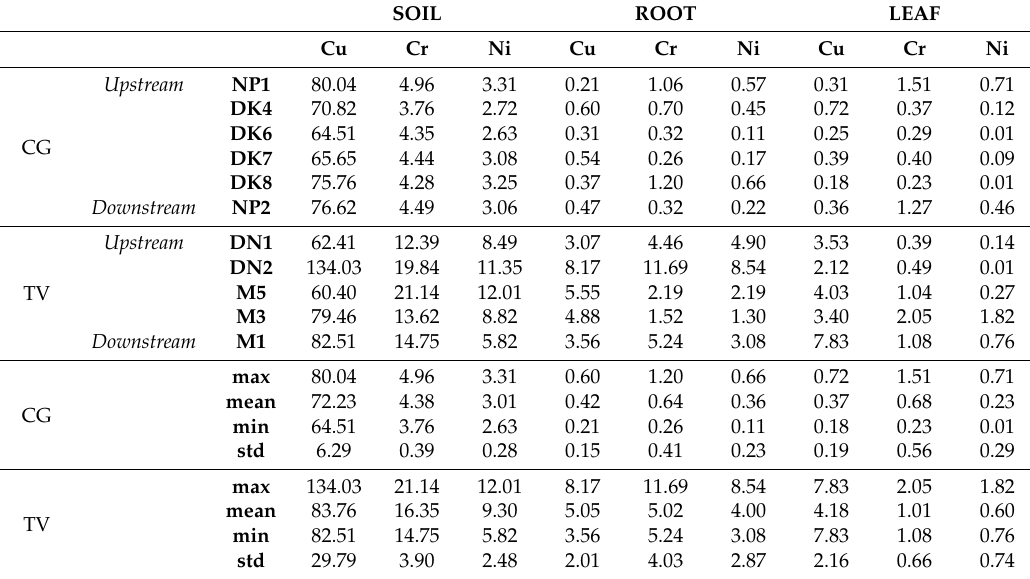
Table 1. Contents (value, max value, mean value, min value and standard deviation std) of the heavy metals Cu, Cr, and Ni (mg / kg) in soil and in tissues of the mangrove species R. apiculata at the 11 sampling